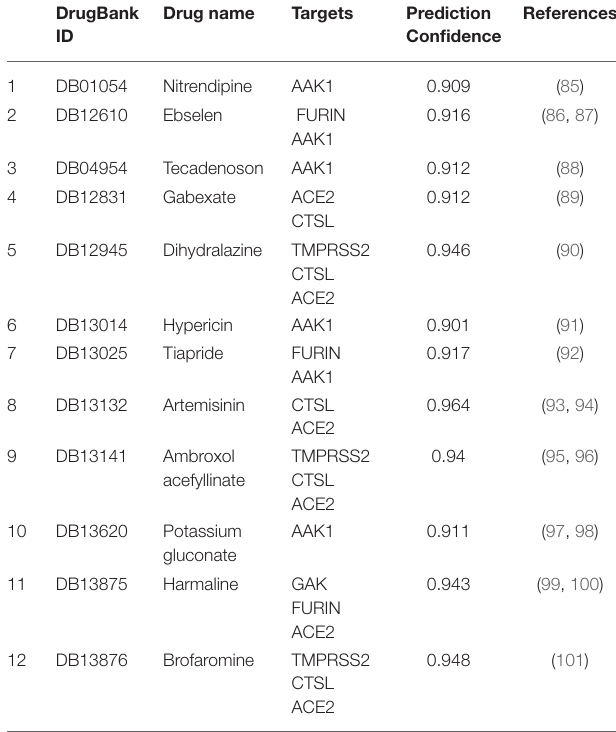
TABLE 4 | Drugs predicted for COVID-19 with their prediction probability and reference